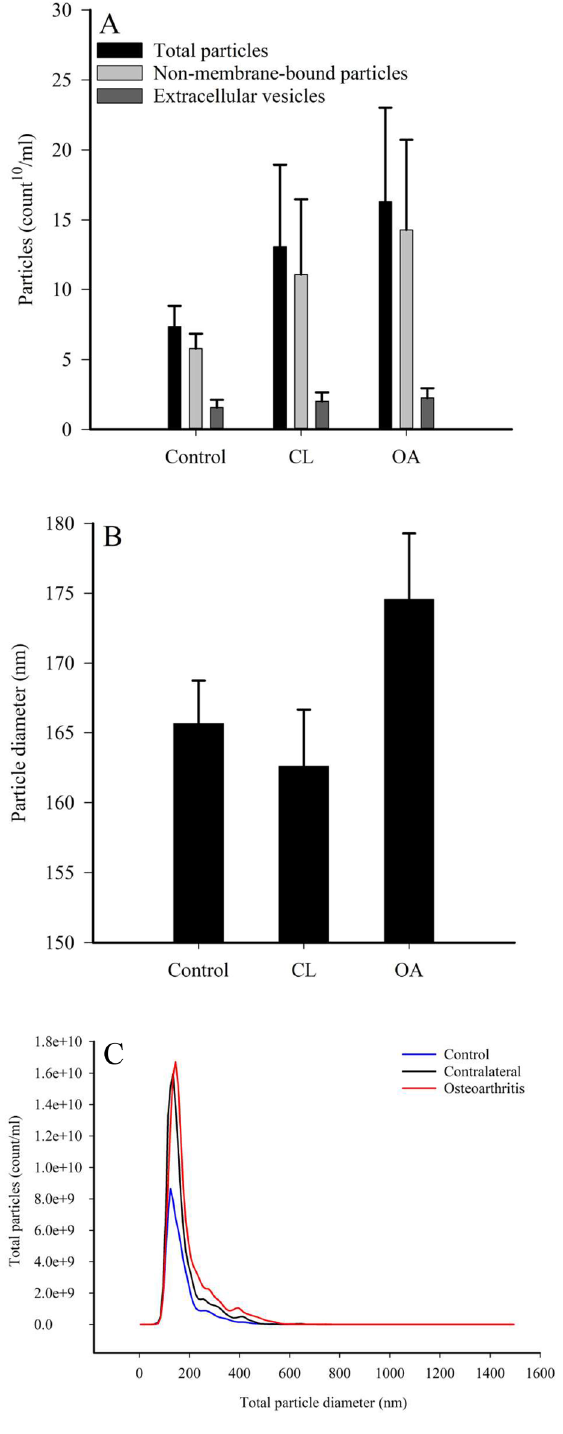
Figure 2. Particle counts ( A ), diameters of total particles ( B ), and size distribution of total particles ( C ) in equine synovial fluids. The samples were collected from control, contralateral (CL), and osteoarthritic (OA) fetlock joints and measured by nanoparticle tracking analysis (means + SE or means). There were no statistically significant differences between the groups (generalized linear model, p >